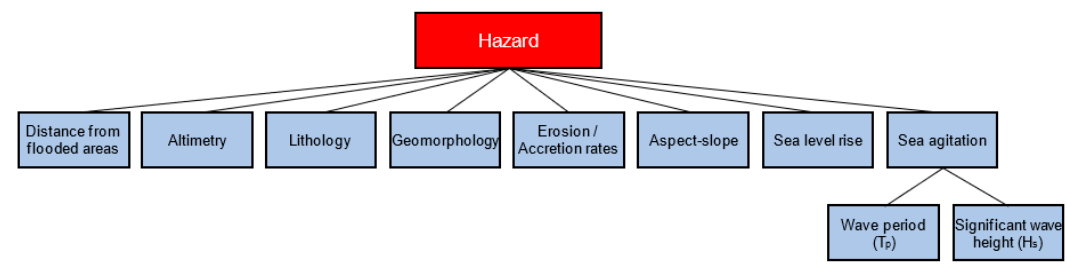
Figure 2. Hazard flow chart with their factors.